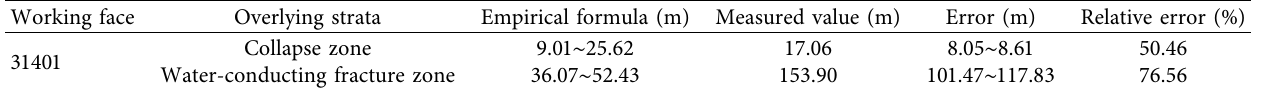
Figure 2: Drillhole column. Table 1: Error analysis of “three zones” height in overlying strata by empirical